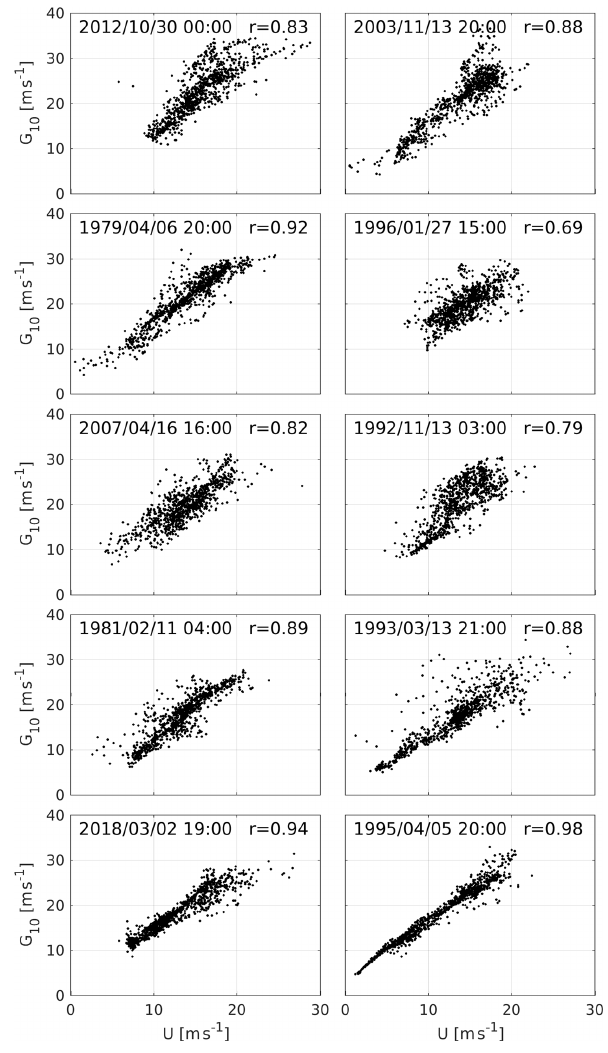
Figure 2. Maximum gust at 10ma.g.l ( G 10 ) vs. hourly 100m wind speed ( U ) in all Northeast grid cells during the peak hour ( t p ) of each of the top 10 storms. The spatial correlation coefficient ( r ) is also given for each